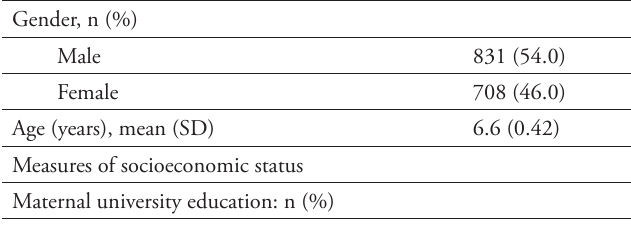
Table 1. Characteristics of the Study